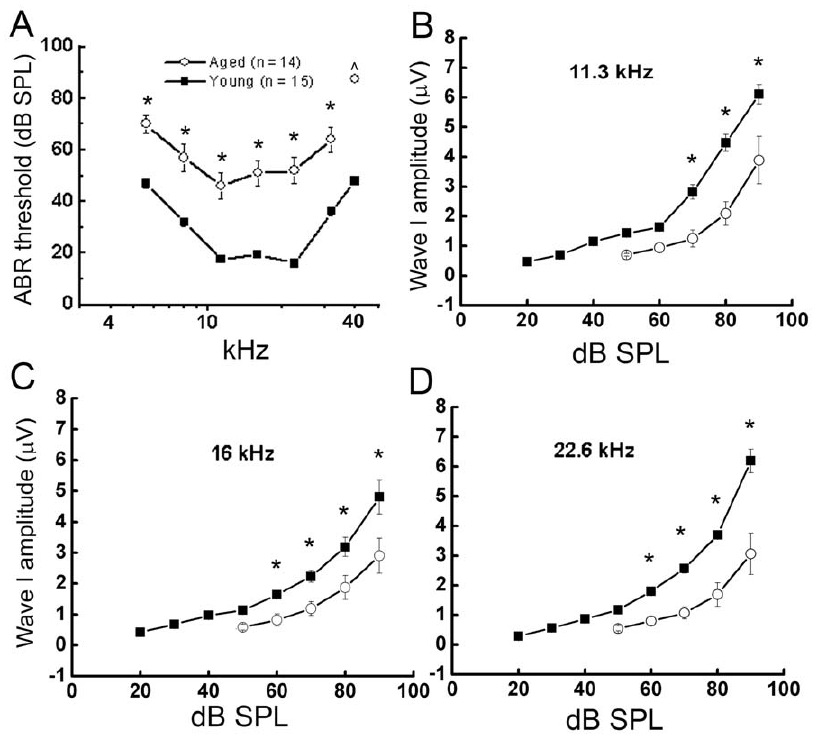
Figure 1. Decline of auditory nerve function in aged CBA/CaJ mice. A: Comparisons of ABR thresholds for wave I obtained from 1–3 month- old and 23–27 month-old mice. It showed significant ABR threshold shifts in older mice across all frequencies tested (5.6, 8, 11.3, 16, 22.6, 32, and 40 kHz). No ABR response was detected at 40 kHz in older mice. B, C, D: Mean wave I amplitude vs. level functions. The data show increased ABR thresholds and decreased wave I amplitudes in aged mice at 11.3, 16, and 22.6 kHz. All data are presented as mean 6 SEM. Asterisks indicated statistically significant differences at the indicated frequencies ( p , 0.05).